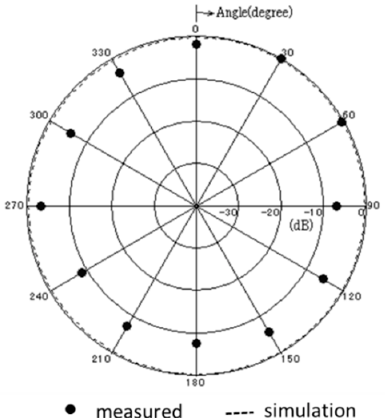
Figure 18. Measured and simulated radiation pattern of the antenna with an impedance matching circuit.